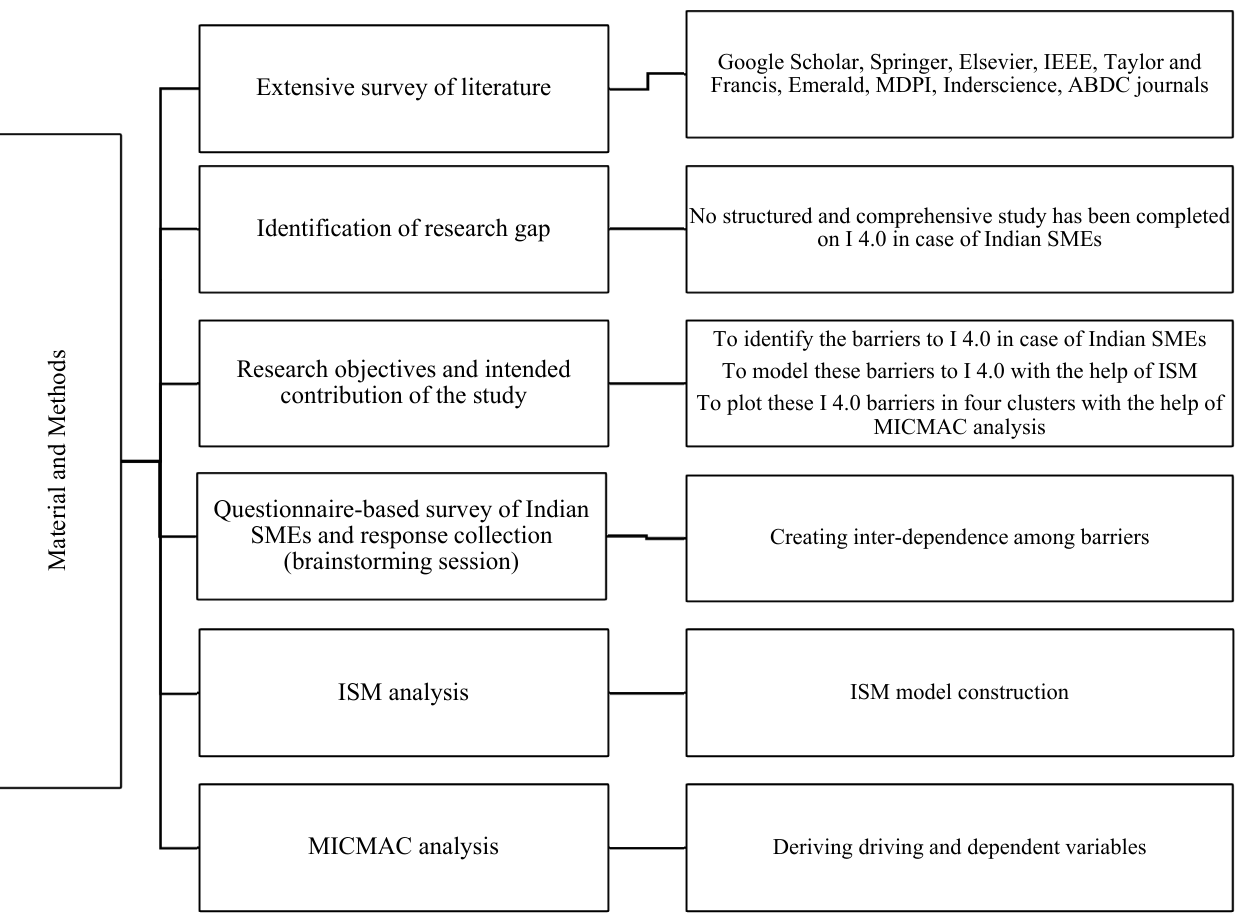
Figure 2. Material and methods used in the present investigation.